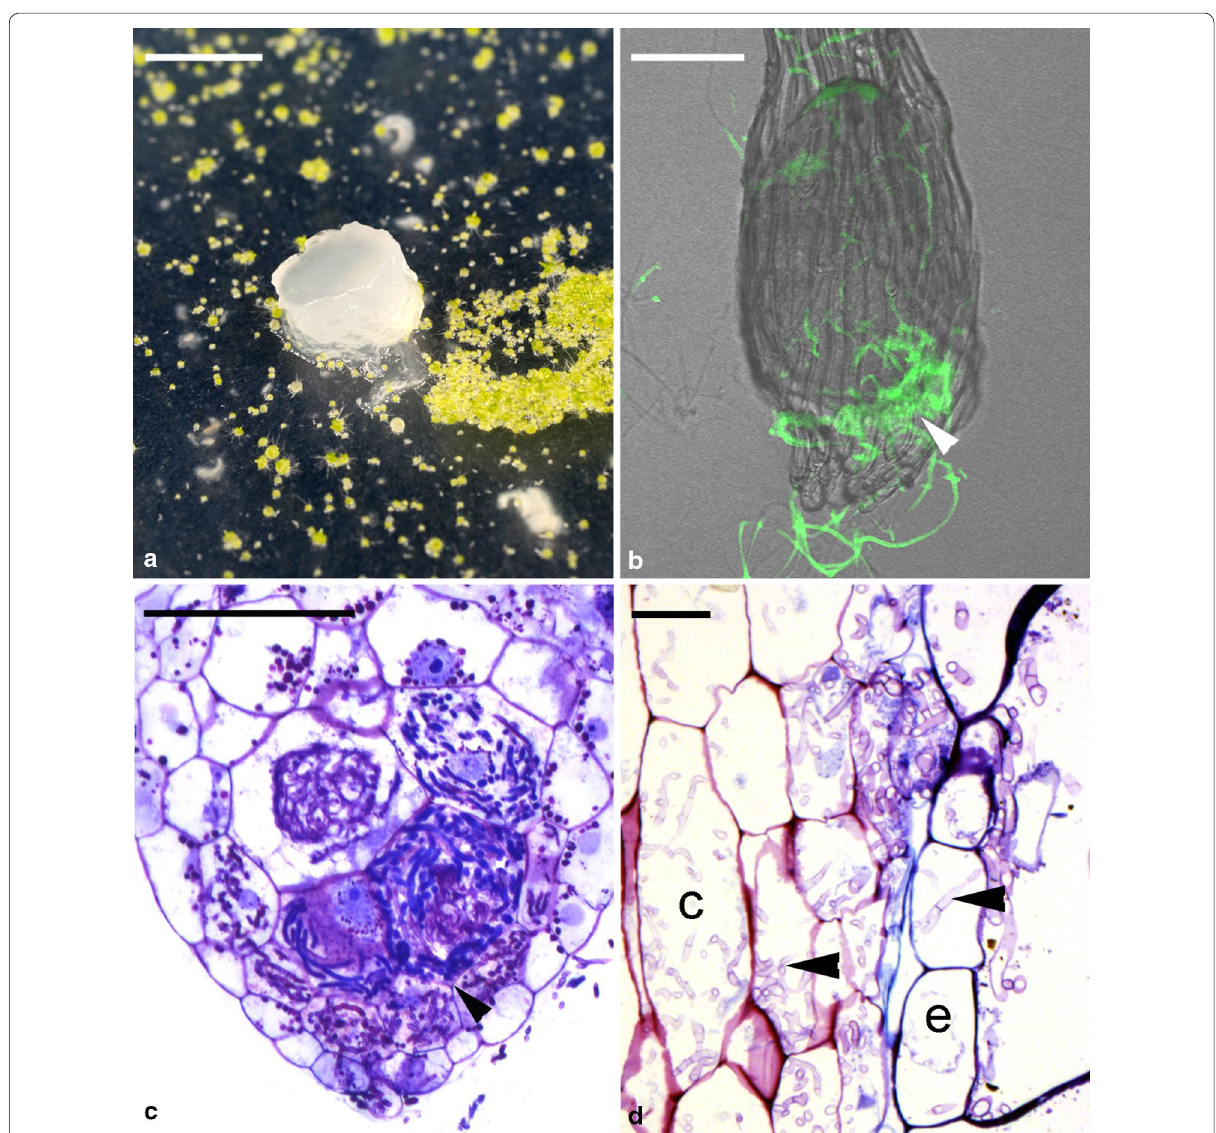
Fig. 2 Symbiotic cultures of D. officinale seeds and seedlings. a Symbiotic seed germination of D. officinale seeds. Protocorms ruptured the seed coats and turned green. Scale bar 10 mm. b Fungal staining using WGA‑FITC (green) showing fungal hyphae (arrowhead) aggregated and = penetrating the suspensor end of embryo. Bar 40 µm. c Longitudinal section of a developing protocorm showing fungal hyphae (arrowhead) = colonizing the basal cortical cells of an enlarged embryo. Scale bar 50 µm. d Longitudinal section of a seedling root showing fungal hyphae = (arrowheads) colonizing the epidermis (e) and cortical cells (c). Scale bar 15 =